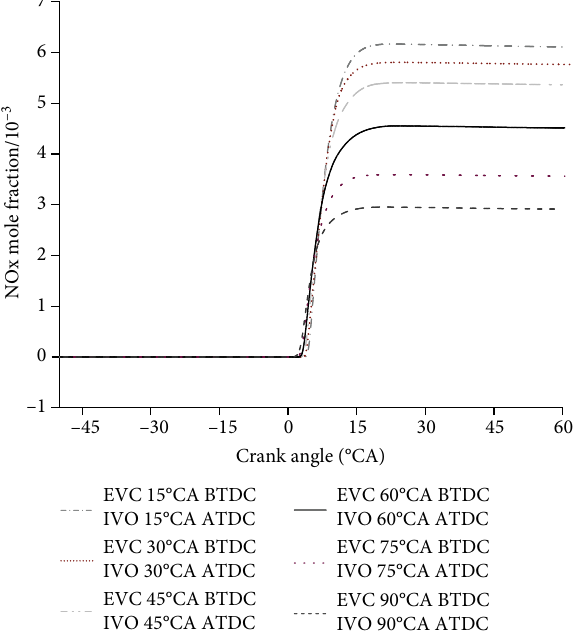
Figure 25: E ff ect of symmetric NVO on NO